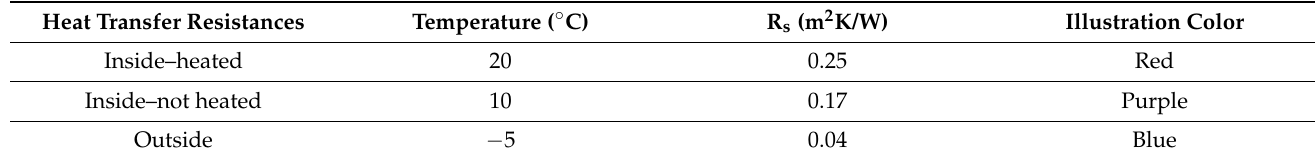
Table A3. List of heat transfer resistances according to the supplementary sheet 2 of DIN 4108